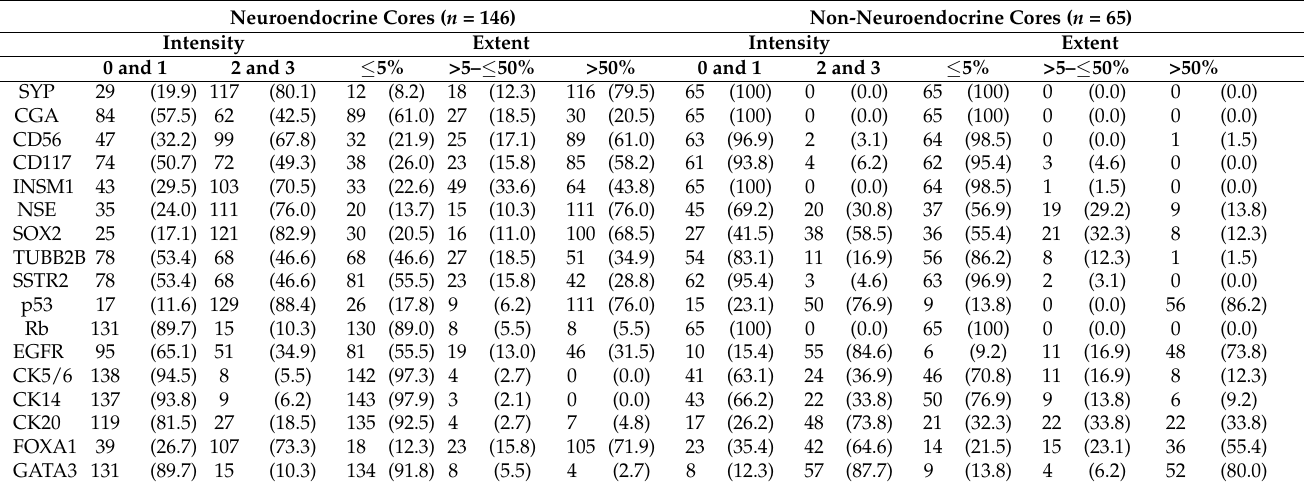
Table 2. Immunoprofile of neuroendocrine cores and non-neuroendocrine cores from small